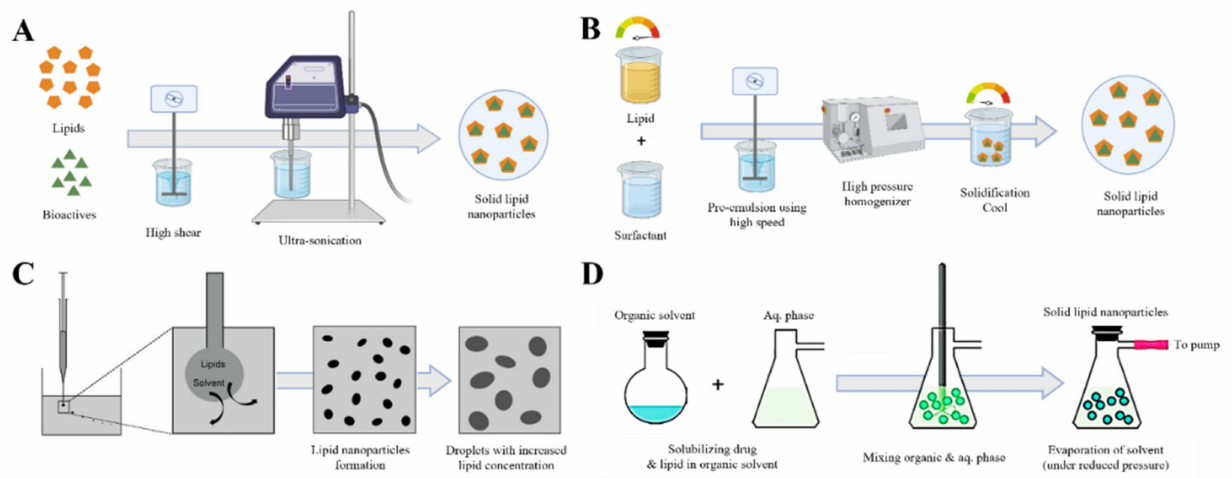
Figure 2. Examples of various LNP emulsification methods. ( A ) Ultra-sonication method. ( B ) High- pressure homogenizer method. ( C ) Solvent injection method. ( D ) Solvent evaporation method. Reproduced with permission from [39] published by Elsevier, 2017, and [37,40] published by MDPI, 2020,